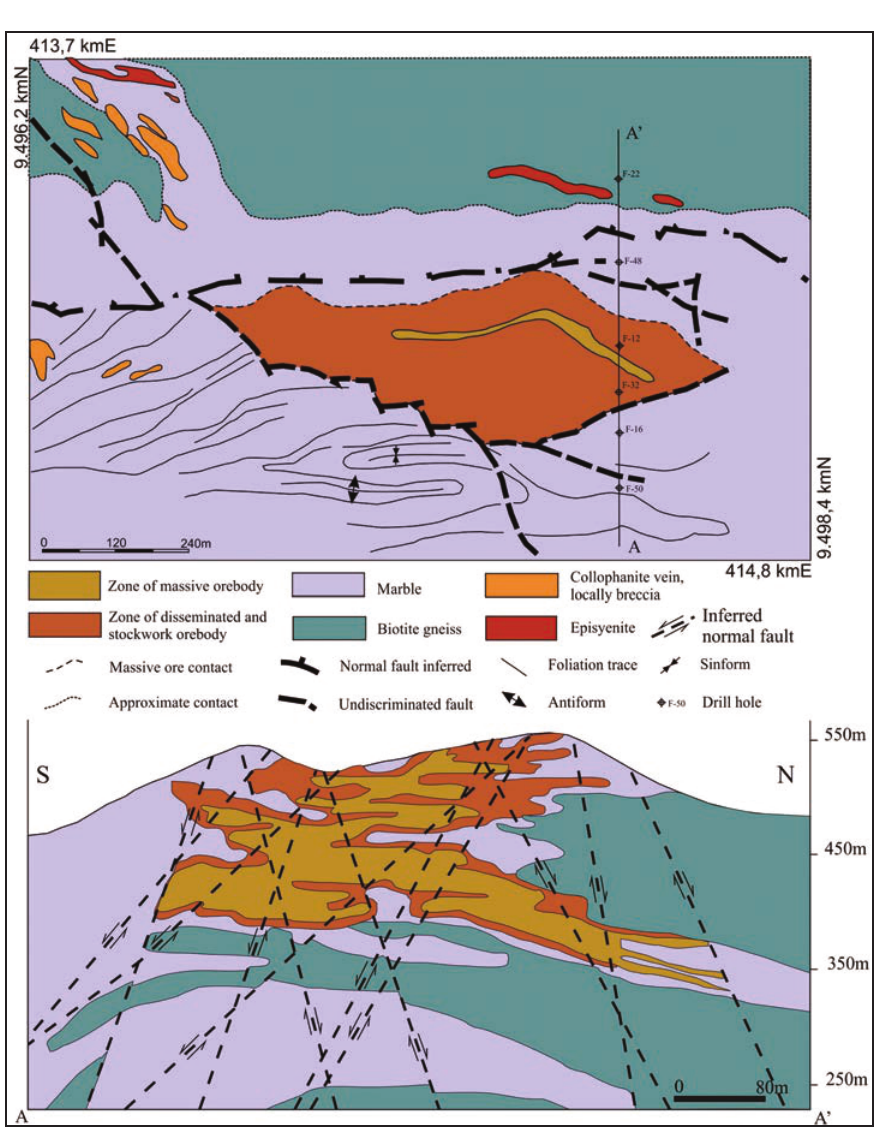
Figure 8 - Geological map and cross-section of the Itataia U-P deposit (compiled from Mendonça et al. 1980; Angeiras